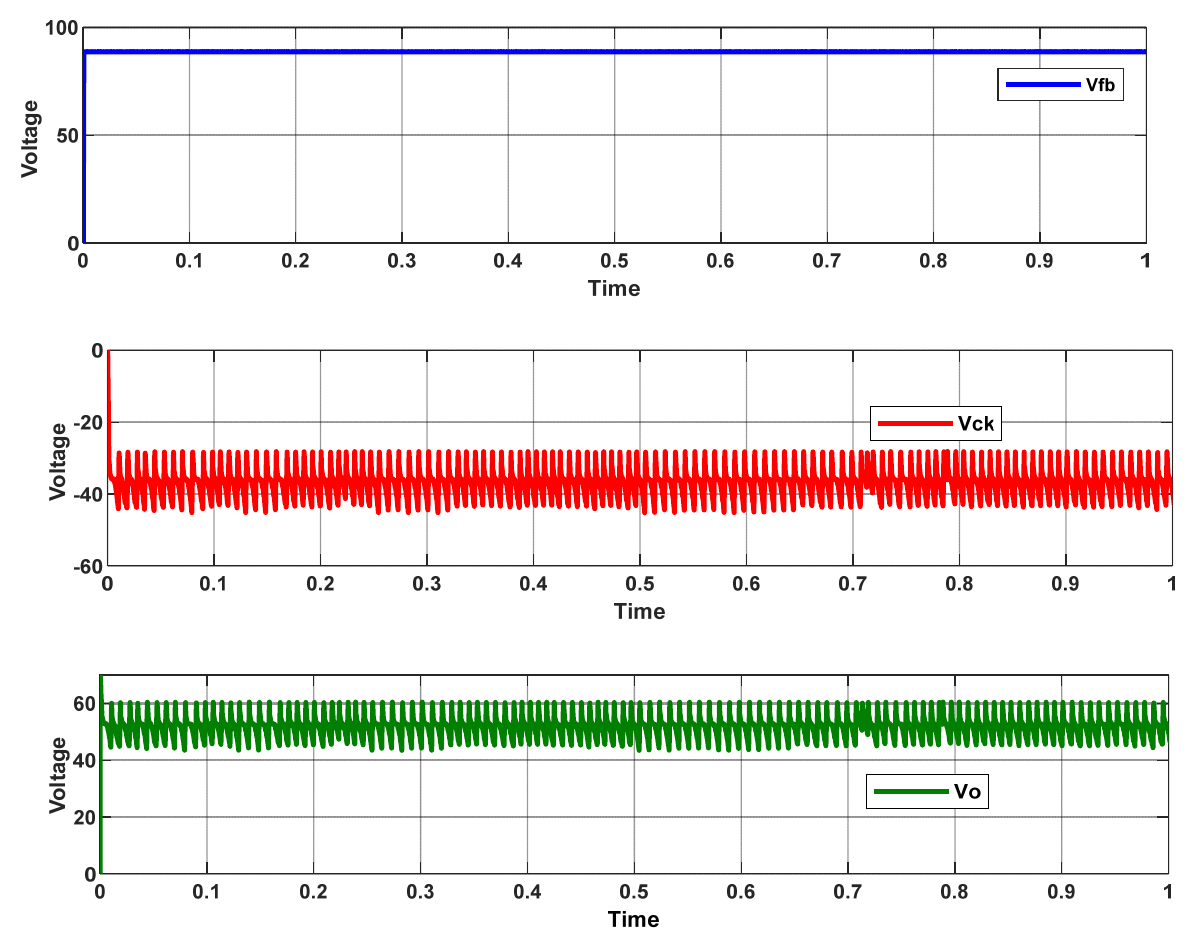
Figure 6. Output voltages, flyback voltage (blue), Cuk voltage (red), and HFC voltage (green).